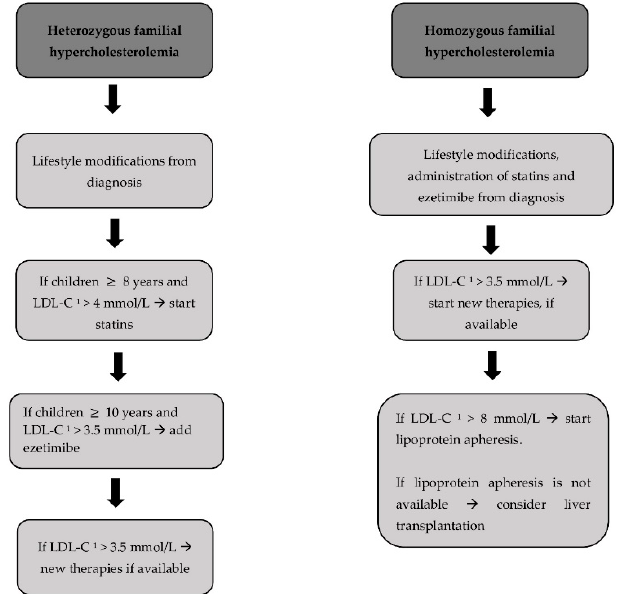
Figure 1. Treatment approach for heterozygous and homozygous familial hypercholesterolemia. LDL-C 1 , low-density lipoprotein cholesterol.